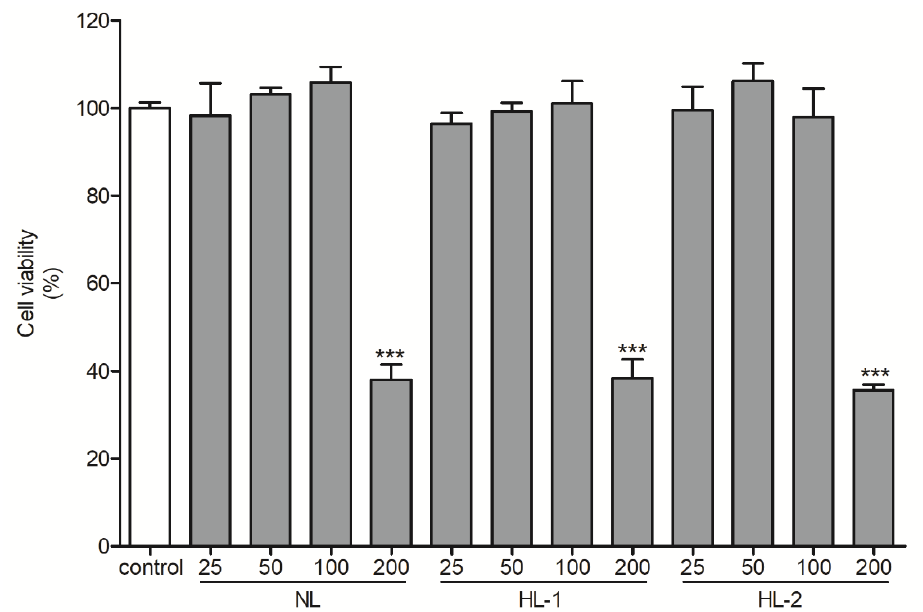
Figure 1. Viability of human dermal fibroblasts following treatment with heat-treated licorice extracts (25–200 µ g/mL) for 24 h. Cell viability was evaluated by MTS assay. The results are shown as the mean ± SD ( n = 3). *** p < 0.001 vs. non-treated control. HL-1, heat-treated licorice (120 ◦ C); HL-2, heat-treated licorice (130 ◦ C); NL, non-treated